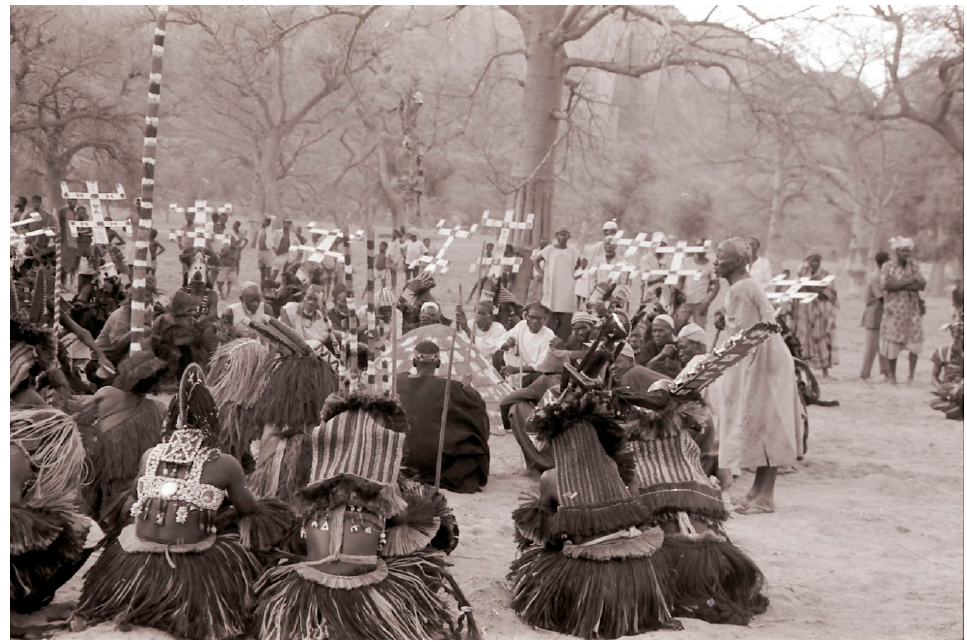
Figure 6. Yedyè, the ritual speaker, addressing the masks of Amani. The dani is on the left, the altar is in the centre behind the elder in black. The mask headpieces are shoved back.